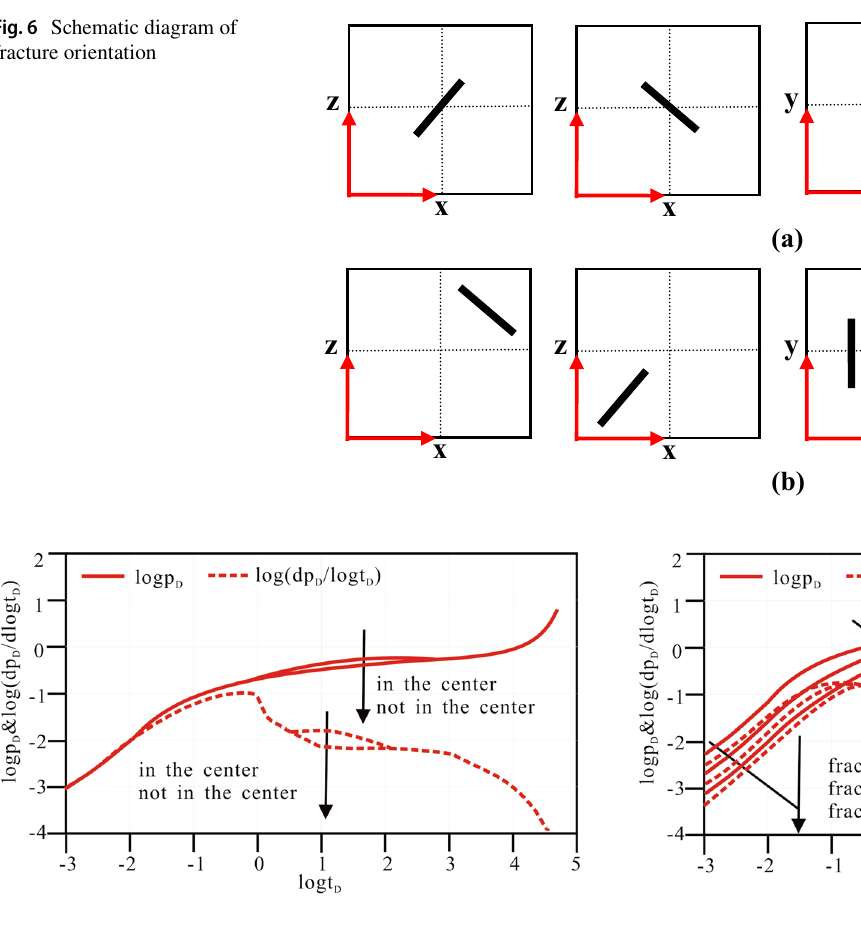
Fig. 7 The effect of fracture orientation on template curves Fig. 8 The effect of fracture length on template